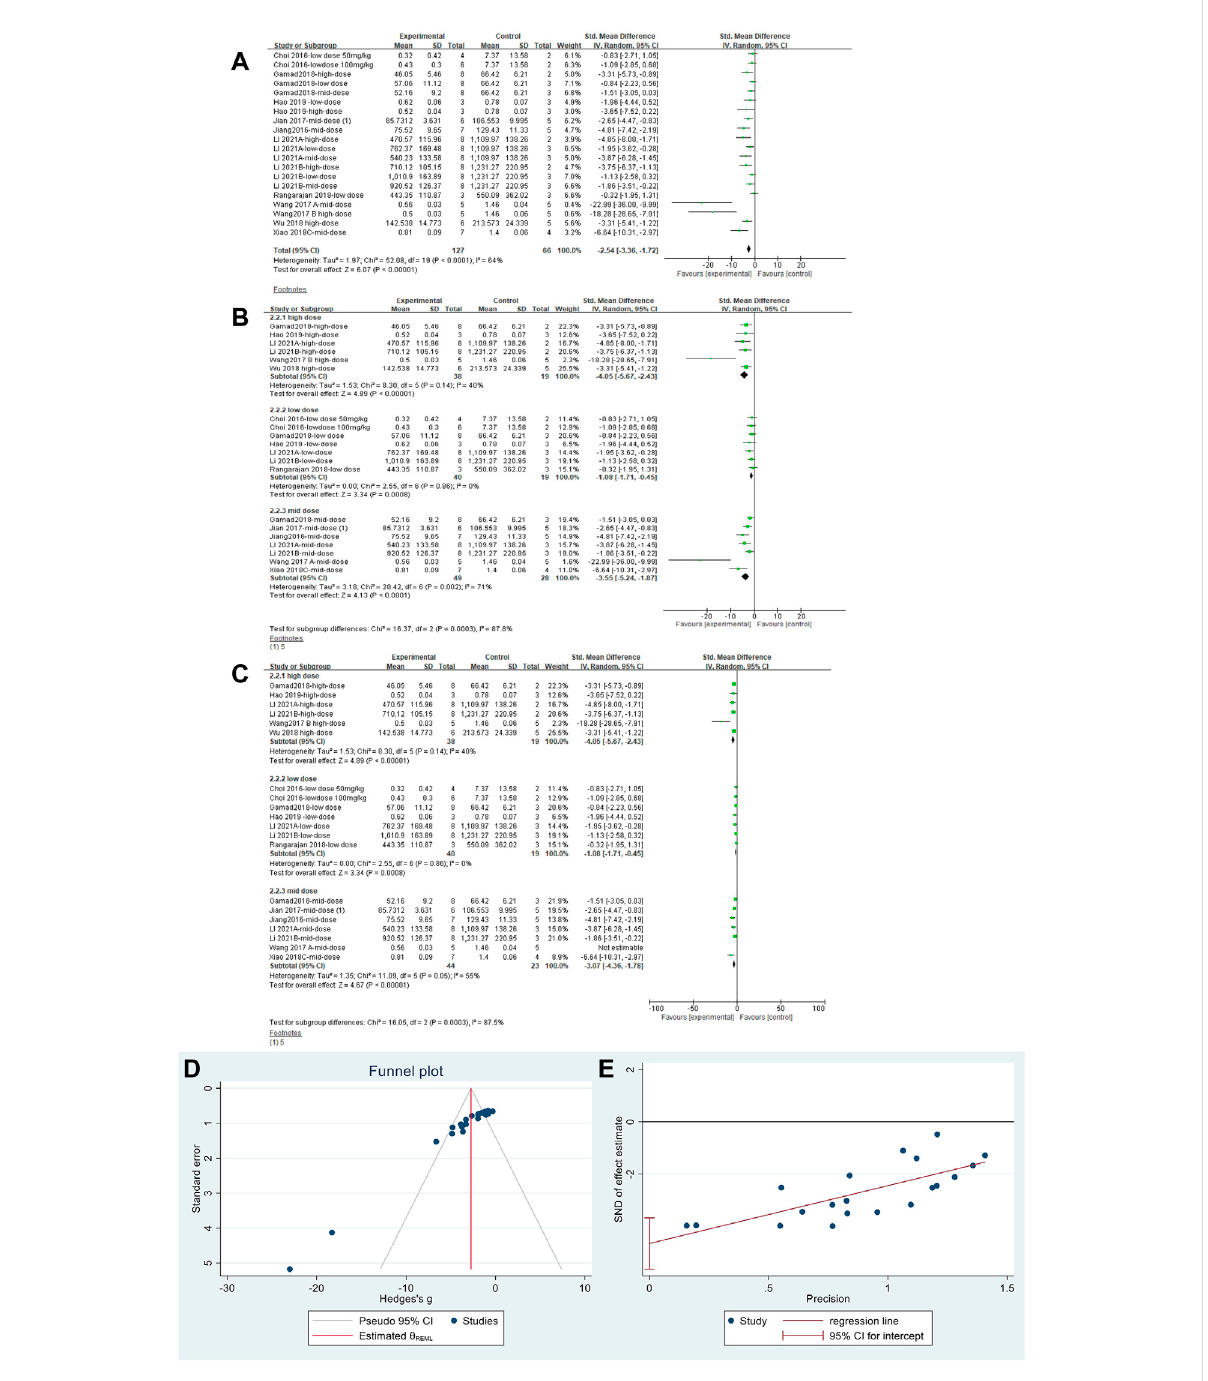
FIGURE 6 Effect of MET on TGF- β in lung tissues of PF animals. (A) Forest plot of TGF- β ; (B) Forest plot of TGF- β (subgroups); (C) Forest plot of TGF- β [subgroups after removing Wang Y. et al., (2017)]; (D) Funnel plot of TGF- β ; (E) . Egger ’ s test for TGF- β